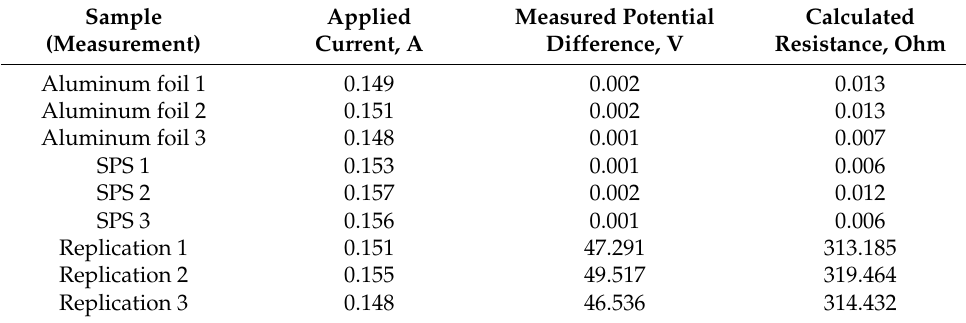
Table 5. The resistance measurement of samples by using the 4-wire testing method.